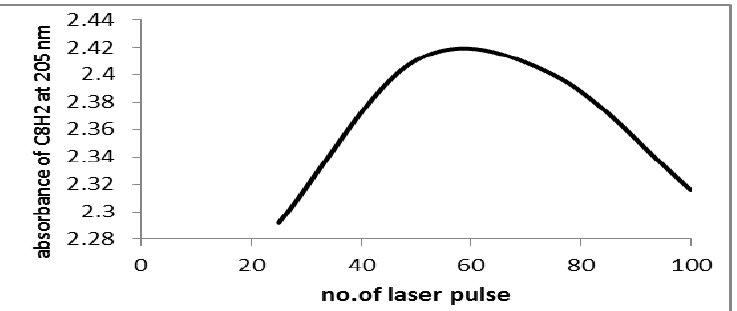
Fig.5: The effects of number of laser pulse on the peak intensities of polyynes (C